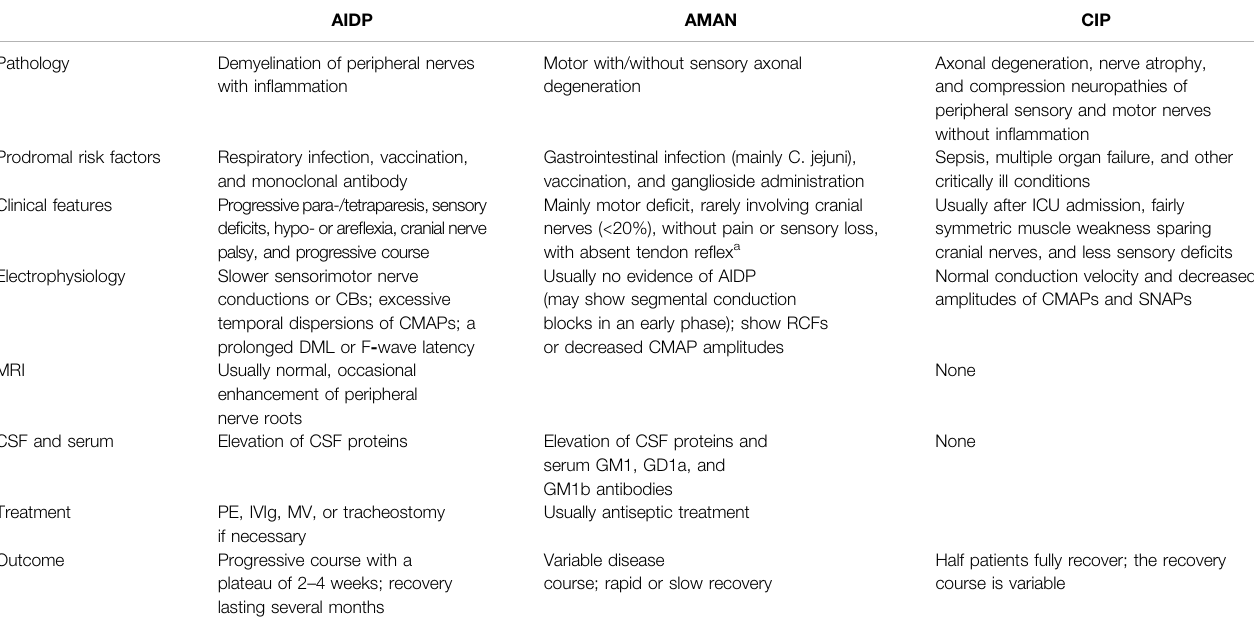
TABLE 3 | Comparisons between major GBS subtypes and CIP (Zhou et al.,